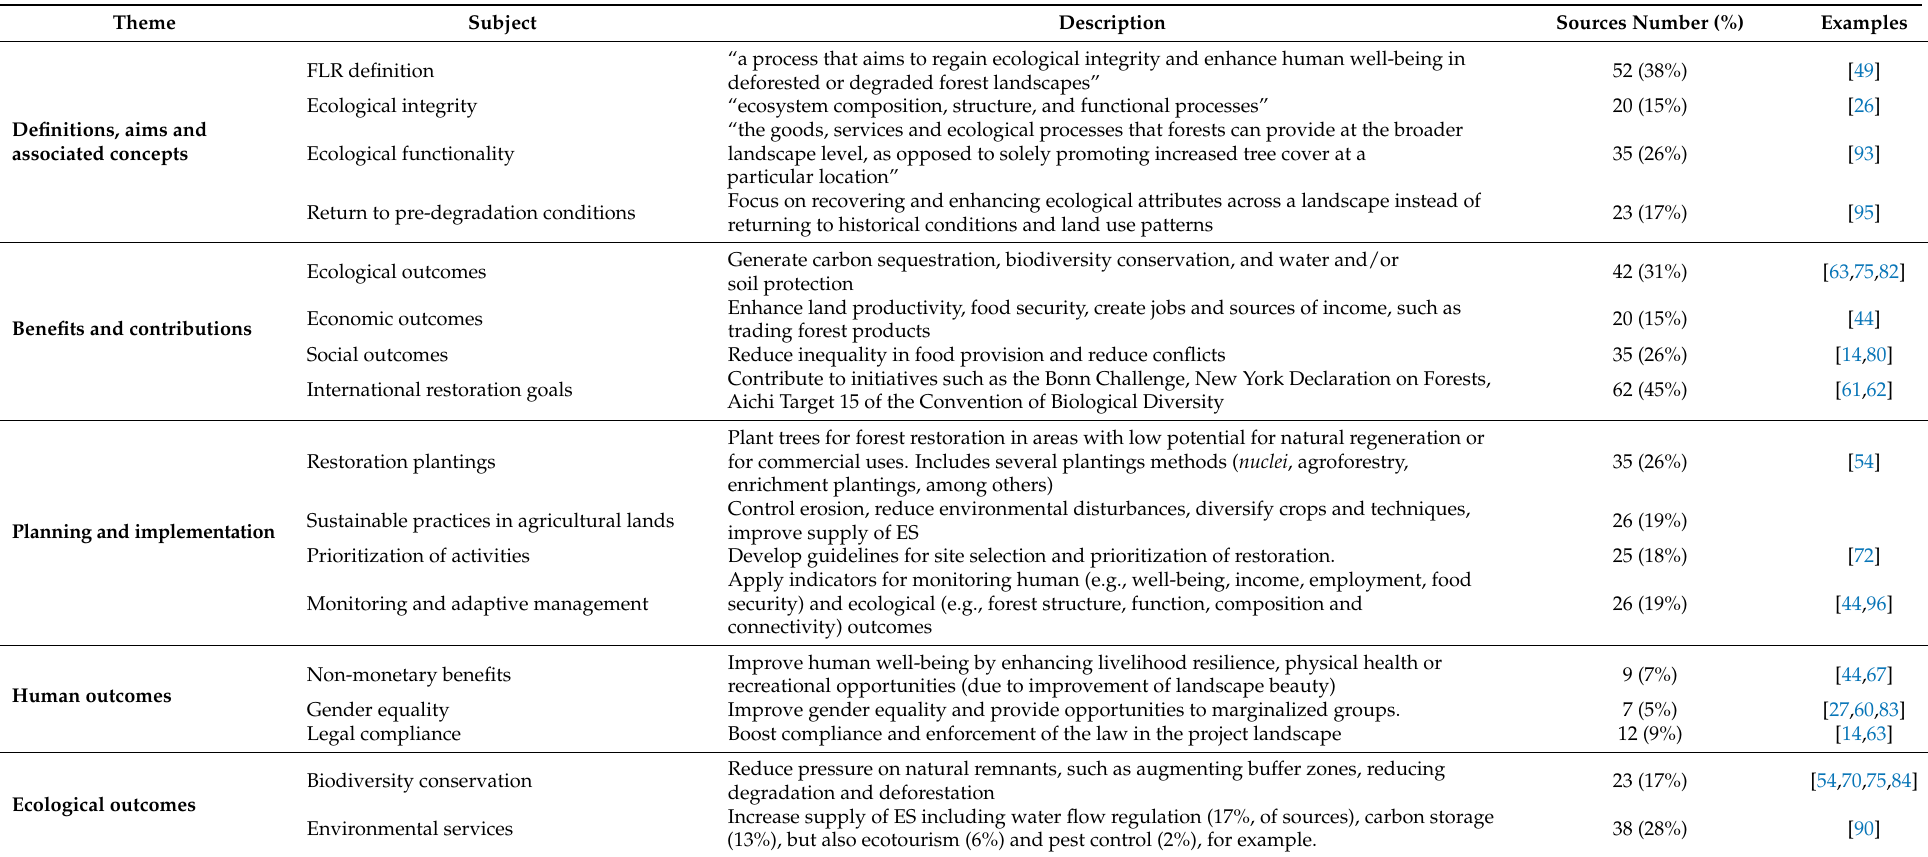
Table 1. Some of the main Forest and Landscape Restoration (FLR) themes addressed by 137 sources sampled in the literature